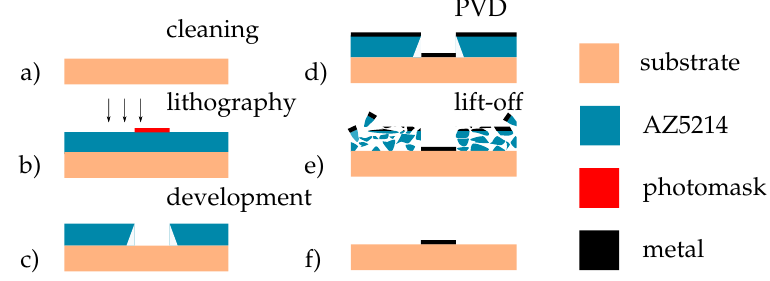
Figure 1. Principles and technological steps of the MEMS-manufacturing process.